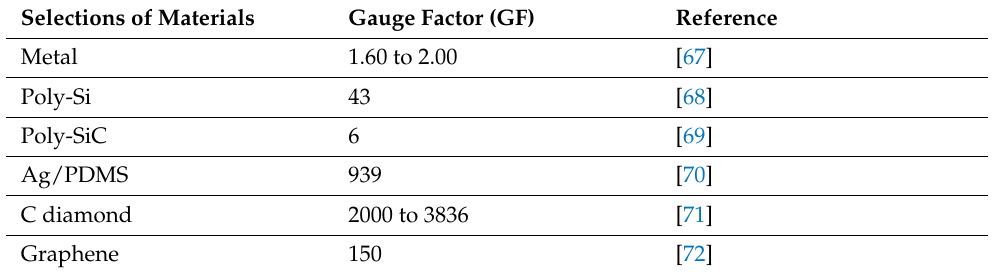
Table 1. Gauge factor of different